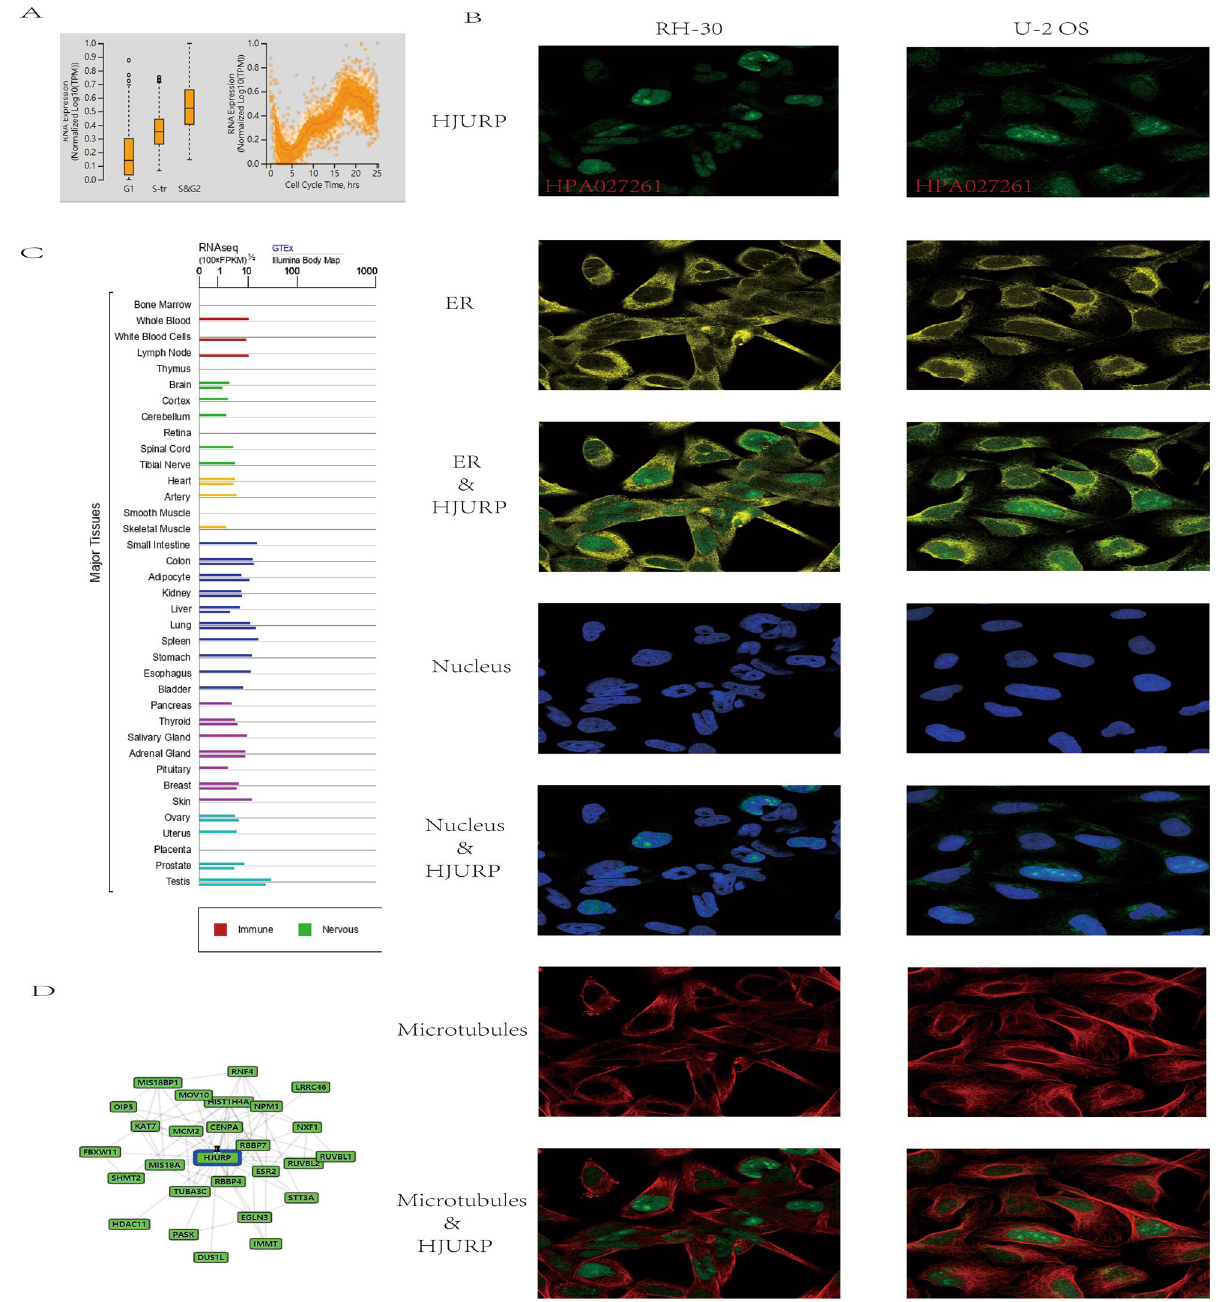
( B ). mRNA of HJURP is expressed in various normal human tissues ( C ). Gene and disease interaction network analysis of HJURP ( D